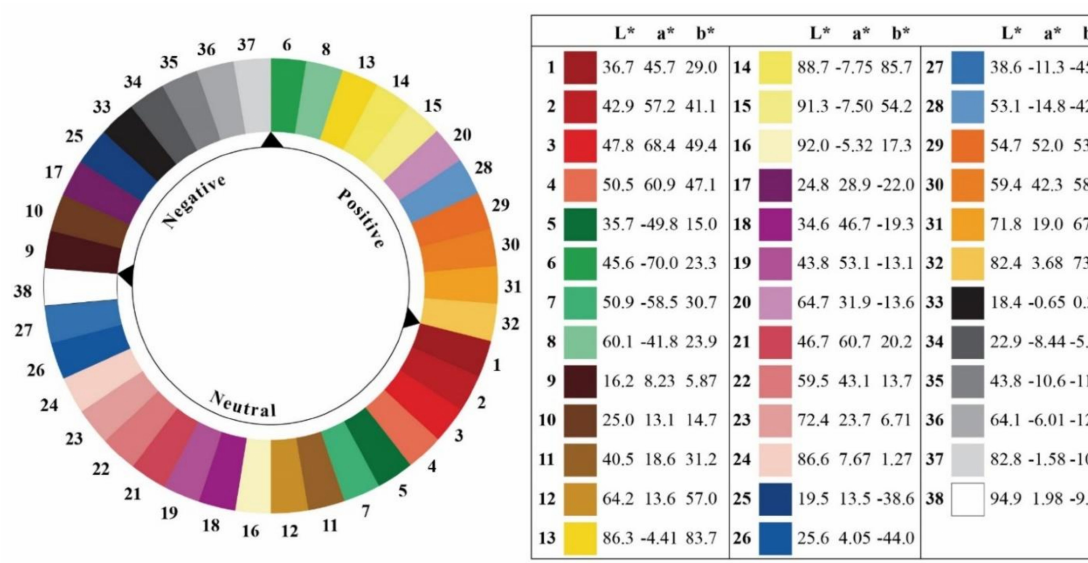
Figure 1. The color matching scheme used in this research. Colors are shown with their corresponding L*a*b* D50 coordinates (CIE 1931; 2 degree